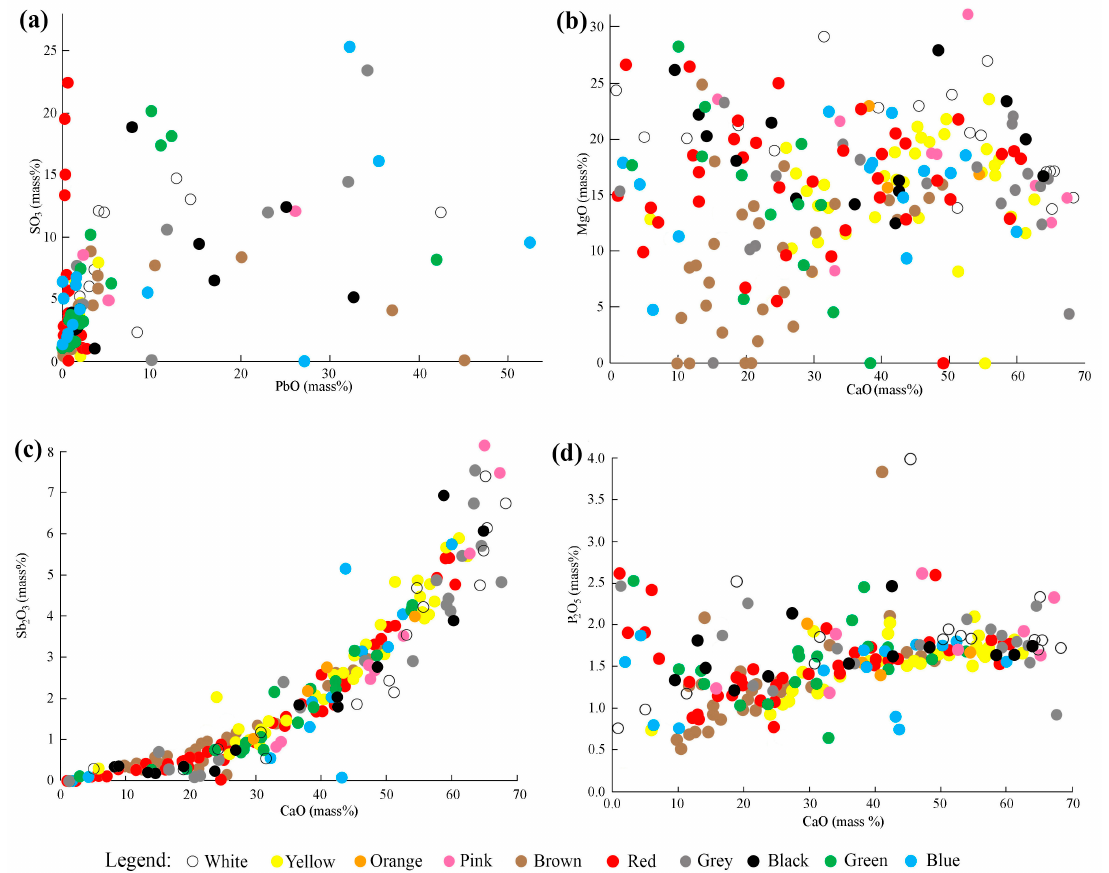
Figure 2. Plot of chemical data for all colors in the discrimination diagrams: ( a ) PbO versus SO 3 ; ( b ) CaO versus MgO; ( c ) CaO versus Sb 2 O 3 ; and ( d ) CaO versus P 2 O 5 .